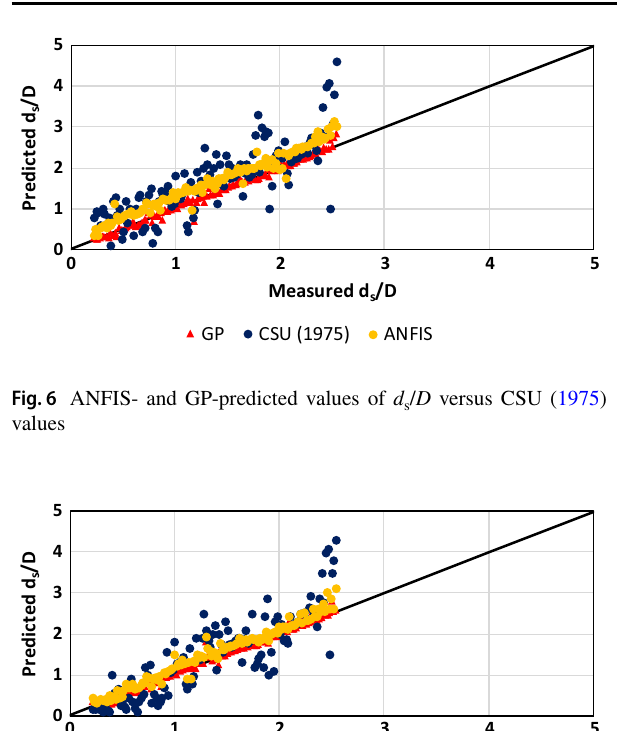
D versus Richardson s /